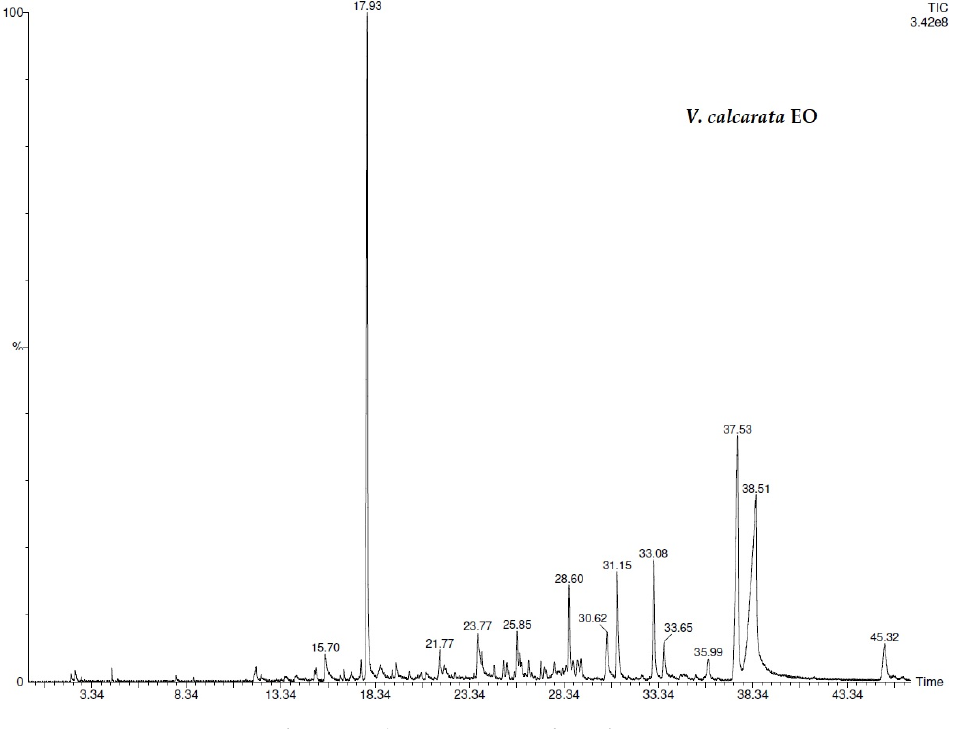
Figure 1. GC/GC-FID chromatograms of V. calcarata EO.